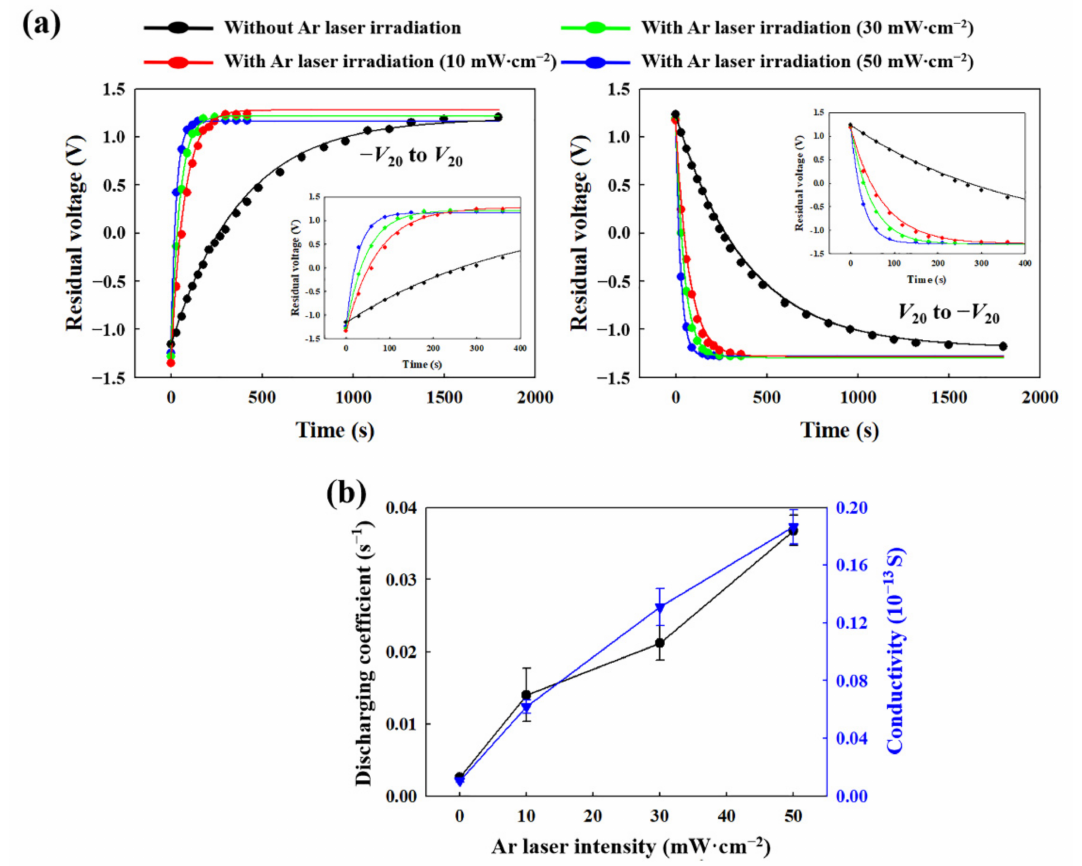
Figure 5. ( a ) Residual voltage dynamics of FFS n -LC modes (fullerene doping density within the high- ρ PI: 0.05 wt%) according to the intensity of Ar laser irradiation. ( b ) Discharging coefficients extracted from ( a